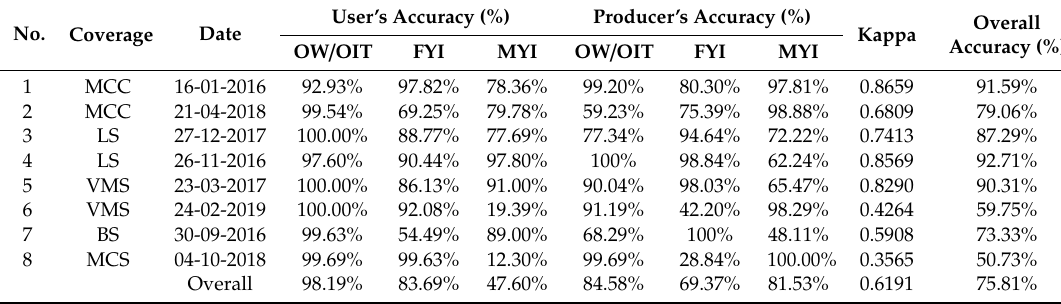
Table 3. Classification results from the TPO method.